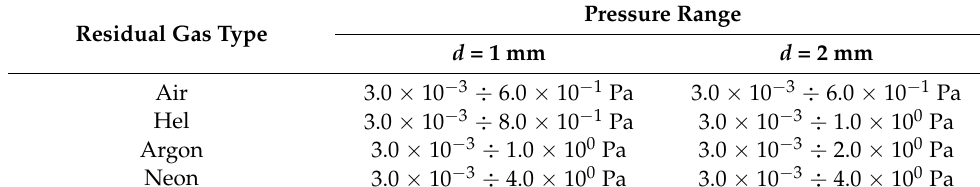
Table 2. The pressure range at which electrical strength measurements were made.